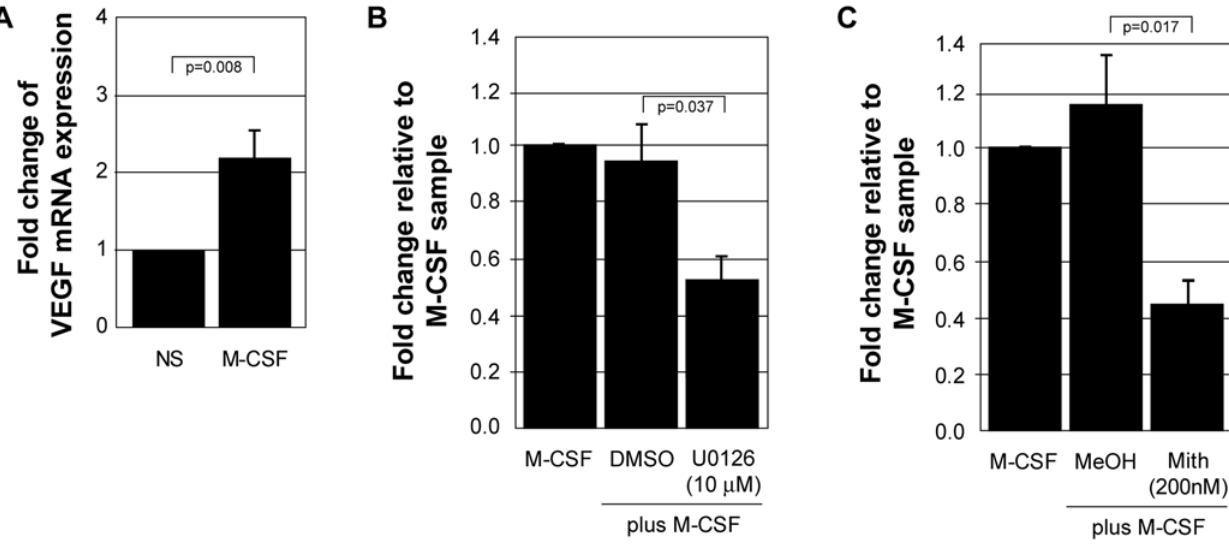
Figure 4. M-CSF regulates VEGF mRNA transcription through ERK and Sp1. A) Freshly isolated human monocytes were cultured overnight in 5% FBS and subsequently starved for 2 hours in minimal media. The cells were stimulated with 100 ng/ml rhM-CSF for 6 hours followed by isolation of RNA. cDNA was synthesized from total cellular RNA, standardized, and subjected to SYBR Green real-time PCR using primers specific for VEGF-A. The data represents the mean + / 2 SEM of six individual donors. B) Freshly isolated human monocytes were cultured overnight in 5% FBS and subsequently starved for 2 hrs followed by pre-treatment with either DMSO (vehicle control) or U0126 (10 m M) in minimal media for 30 minutes. The cells were then stimulated with 100 ng/ml rhM-CSF (M-CSF) , (M-CSF + DMSO) , (M-CSF + U0126 10 m M) and analyzed as stated in A . The data represents the mean + / 2 SEM of three individual donors. C) Freshly isolated human monocytes were cultured overnight in 5% FBS and subsequently starved for 2 hours followed by pre-treatment with either methanol (vehicle control) or mithramycin (200 nM) in minimal media. The cells were then stimulated with 100 ng/ml rhM-CSF (M-CSF) , (M-CSF + MeOH) , (M-CSF + Mith (200 nM)) and analyzed as in A . The data represents the mean + / 2 SEM of four individual